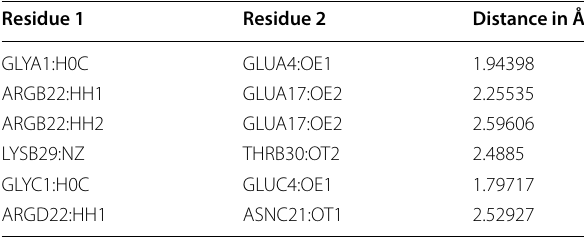
Table 3 Insugen (I) residues involved in salt bridge